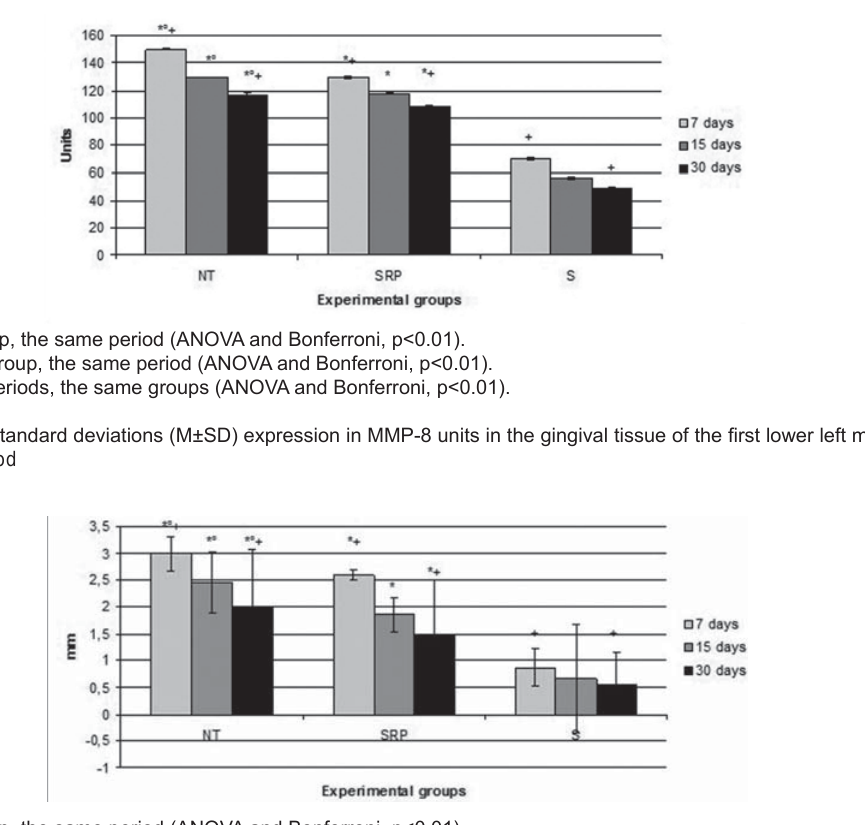
Figure 2- Means and standard deviations (M±SD) of the distances between the cementum-enamel union and alveolar bone crest (mm)